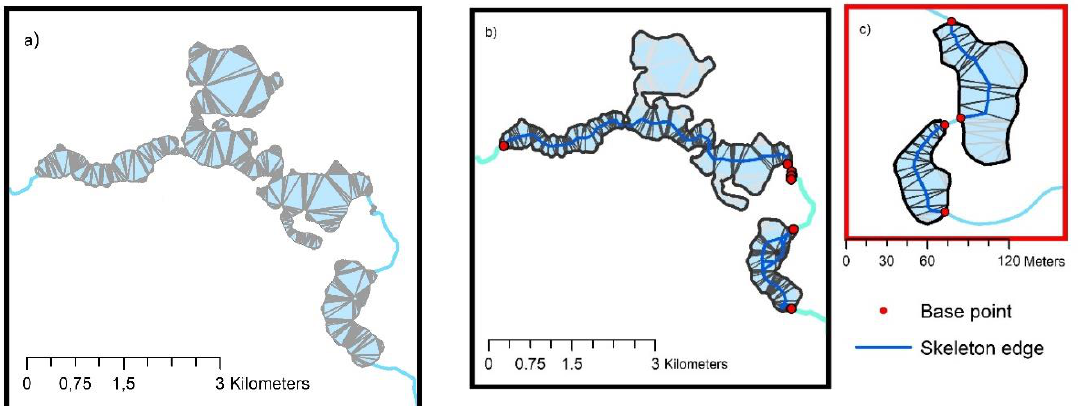
Figure 17. Skeleton of a hydrographic network generated with the BPSplit algorithm based on the selected base points: ( a ) TIN edges in polygons (lakes); ( b ) the selected TIN edges; ( c ) two small lakes with the selected TIN edges.